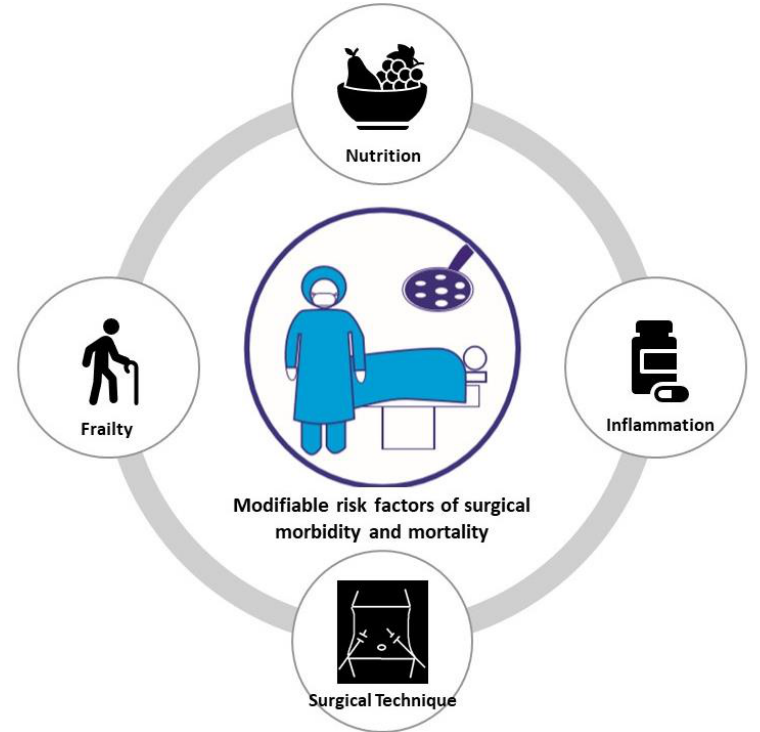
Figure 1. Summary of modifiable risk factors influencing postoperative outcomes.